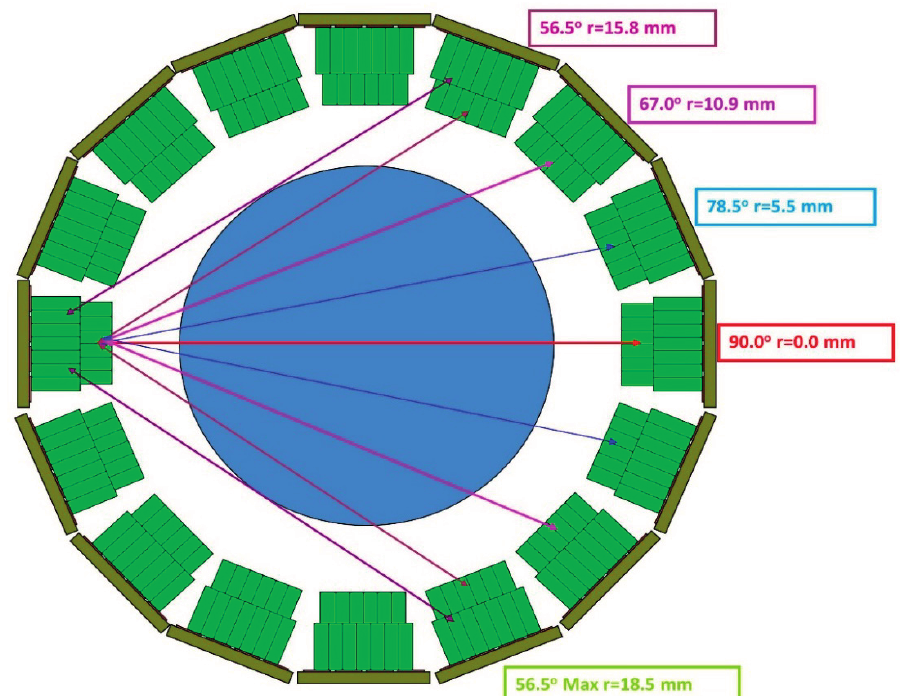
Figure 13. Trans-axial view of the detectors and a disk covering the imaging field of view. The colored chords show lines of response which intersect the crystals more obliquely as they are further from